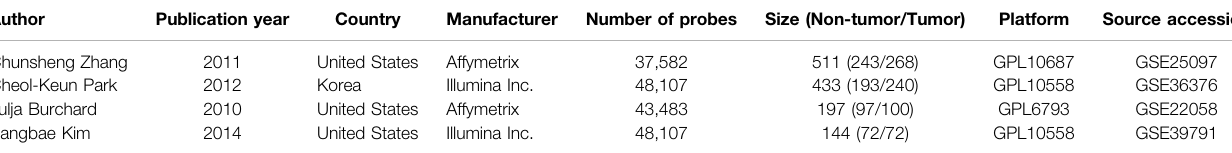
TABLE 1 | Basic characteristics of the included HCC dataset.